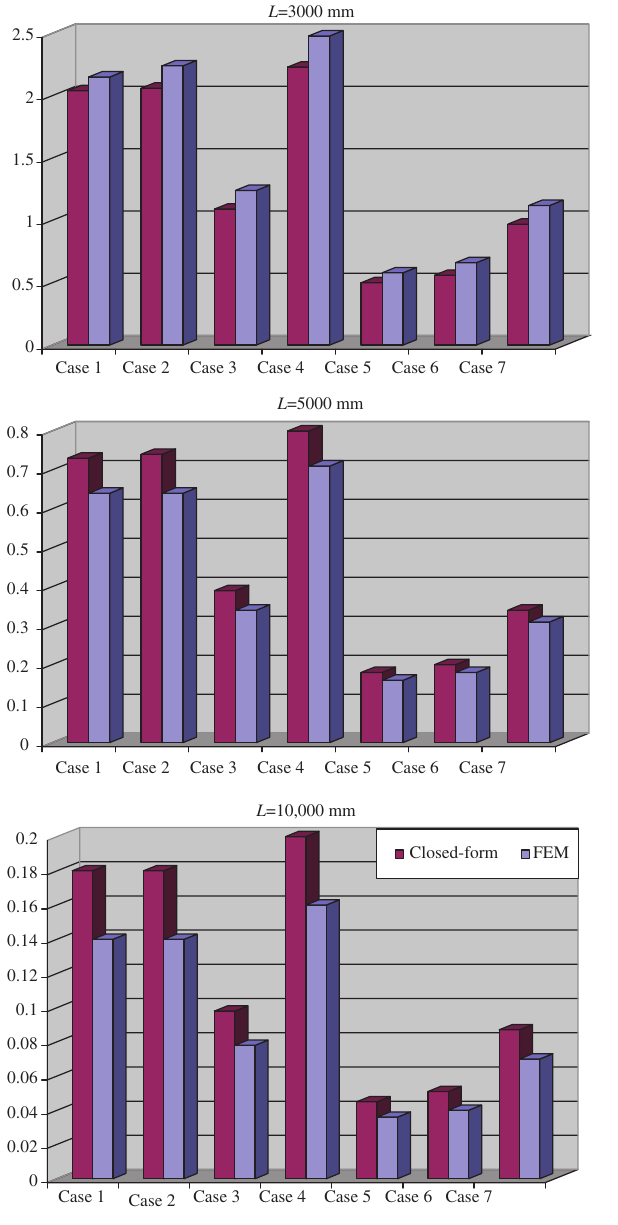
Figure 5 Comparisons of normalized buckling results for I-shaped section.